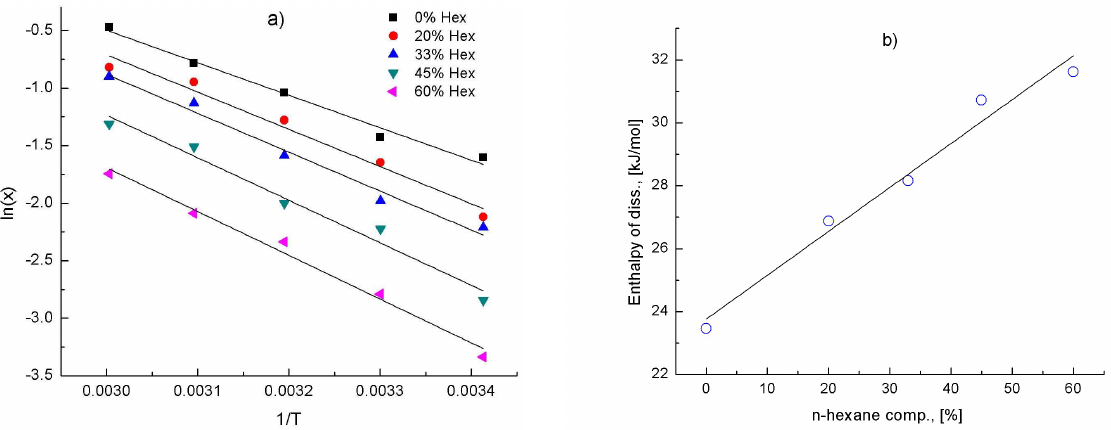
Figure 4. ( a ) Van ’t Hoff plots; ( b ) enthalpy of dissolution of L-lactide vs. solvent composition.